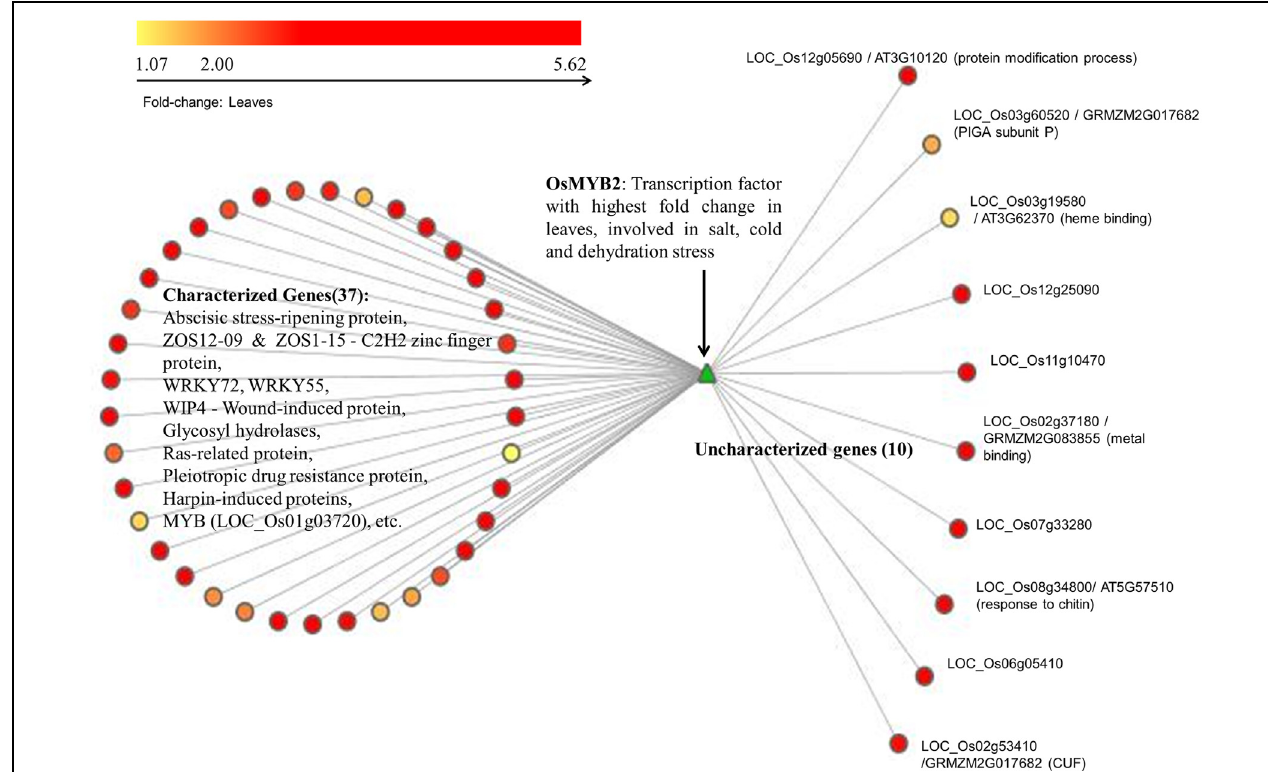
FIGURE 4 | Uncharacterized neighbors of OsMYB2 in green module. The R2R3 transcription factor, OsMYB2 is depicted in green. Its first neighbors are depicted according to the fold change observed in leaves. Among these, 37 are characterized and 10 are uncharacterized proteins.